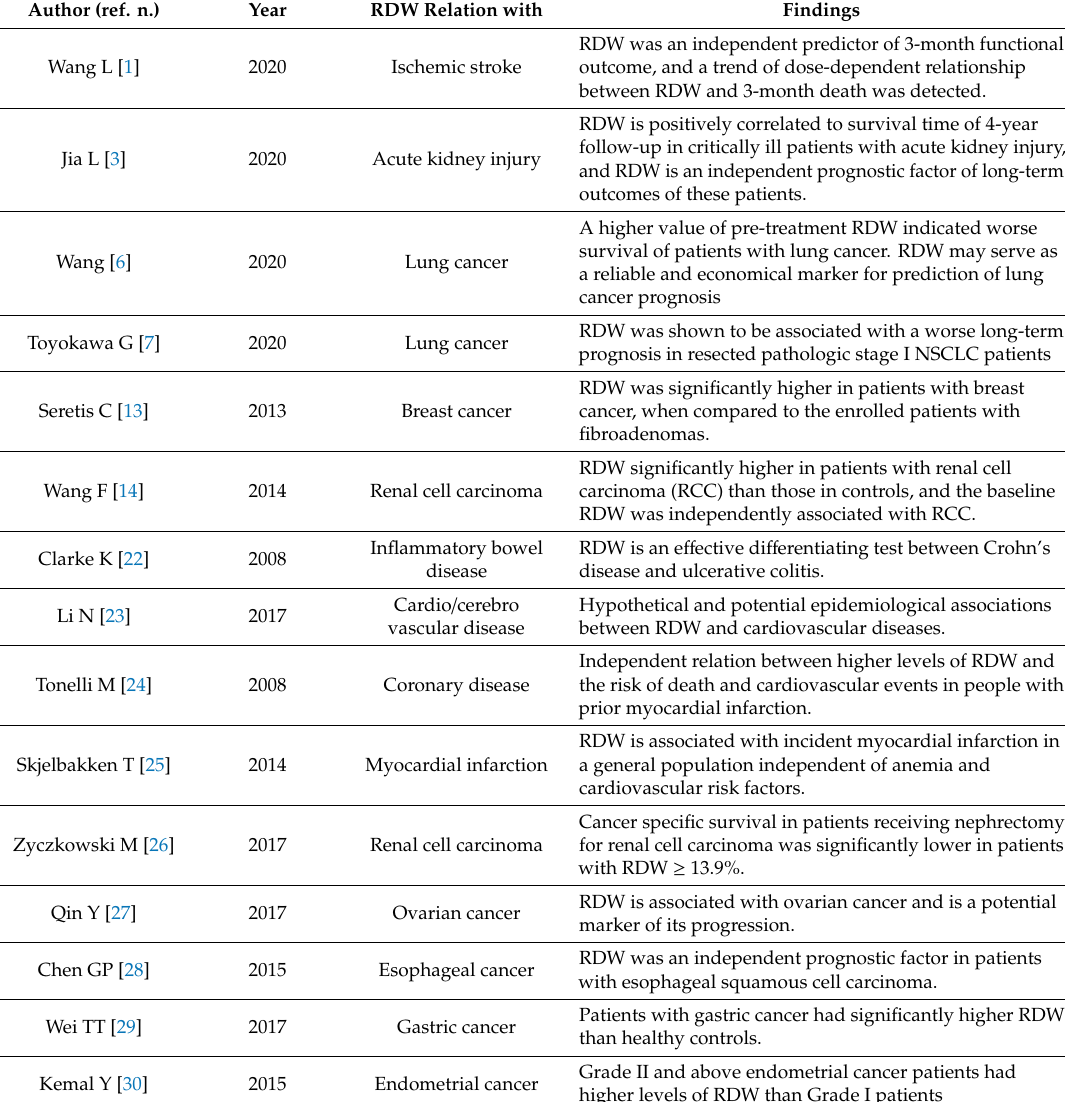
Table 1. Association between Red blood cell distribution width (RDW) and diseases in recent literature. Author (ref.